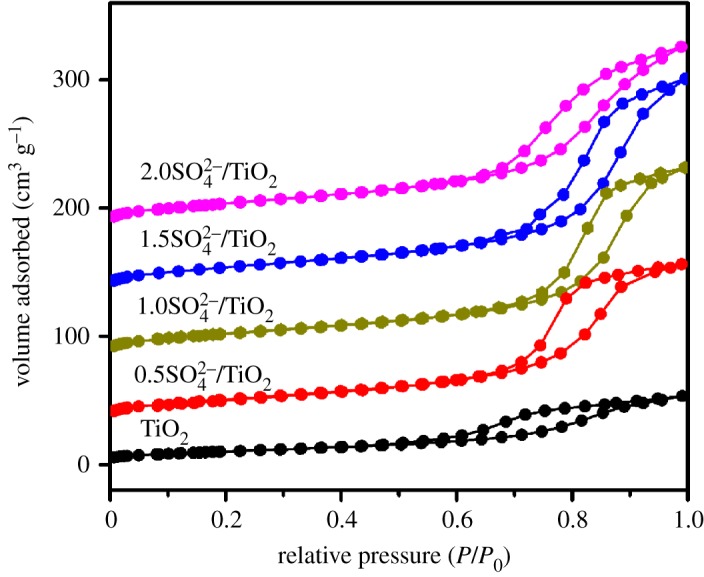
Nitrogen physisorption curves of the TiO2 and SO42−/TiO2 samples.